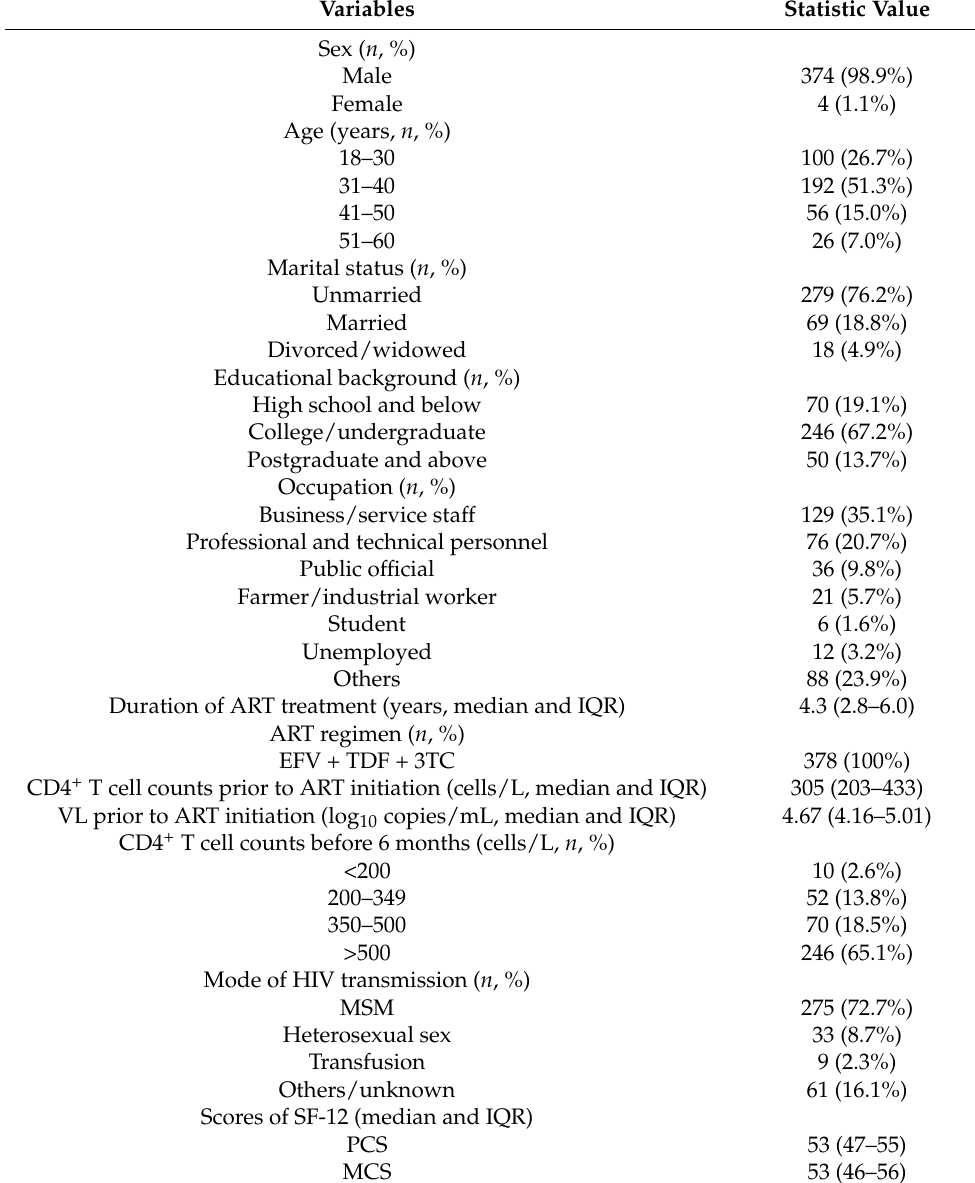
Table 1. Demographics, HIV characteristics, and health status of PLWH ( n =